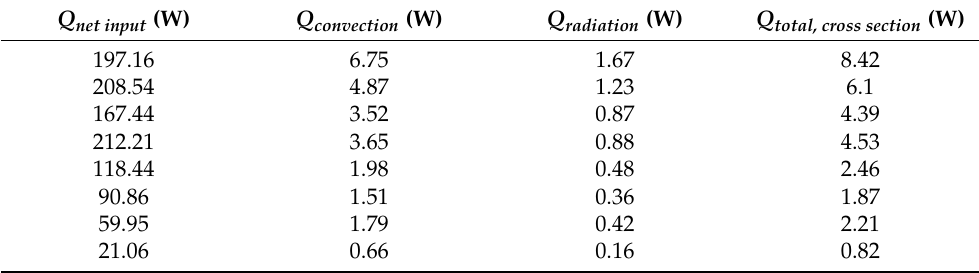
Table 4. Total heat transfer due to convection and radiation from a cross section of PV cell.